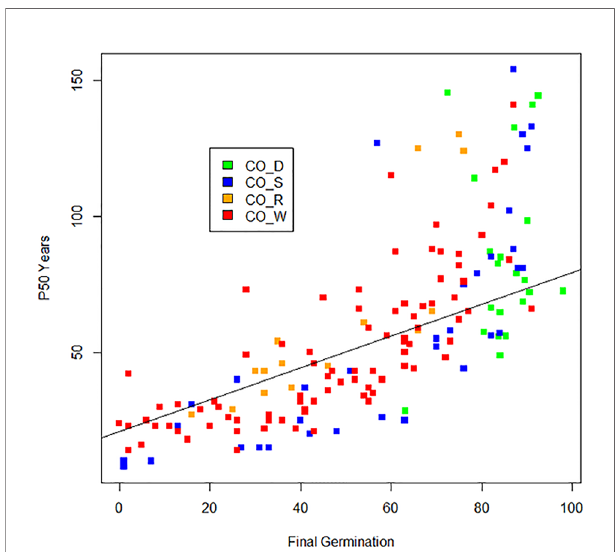
FIGURE 2 | Boxplots of the estimated P 50 (the time in years until the seeds in a given lot have lost 50% of their initial viability). Results of the four studies under cold storage: Desheva (2016): CO_D; Stanwood (see Walters et al., 2005): CO_S, Walters et al. (2005): CO_W; Roos and Davidson (1992): CO_R; and the two studies under ambient storage: Priestley et al. (1985): AM_P and Nagel and Börner (2010): AM_N.